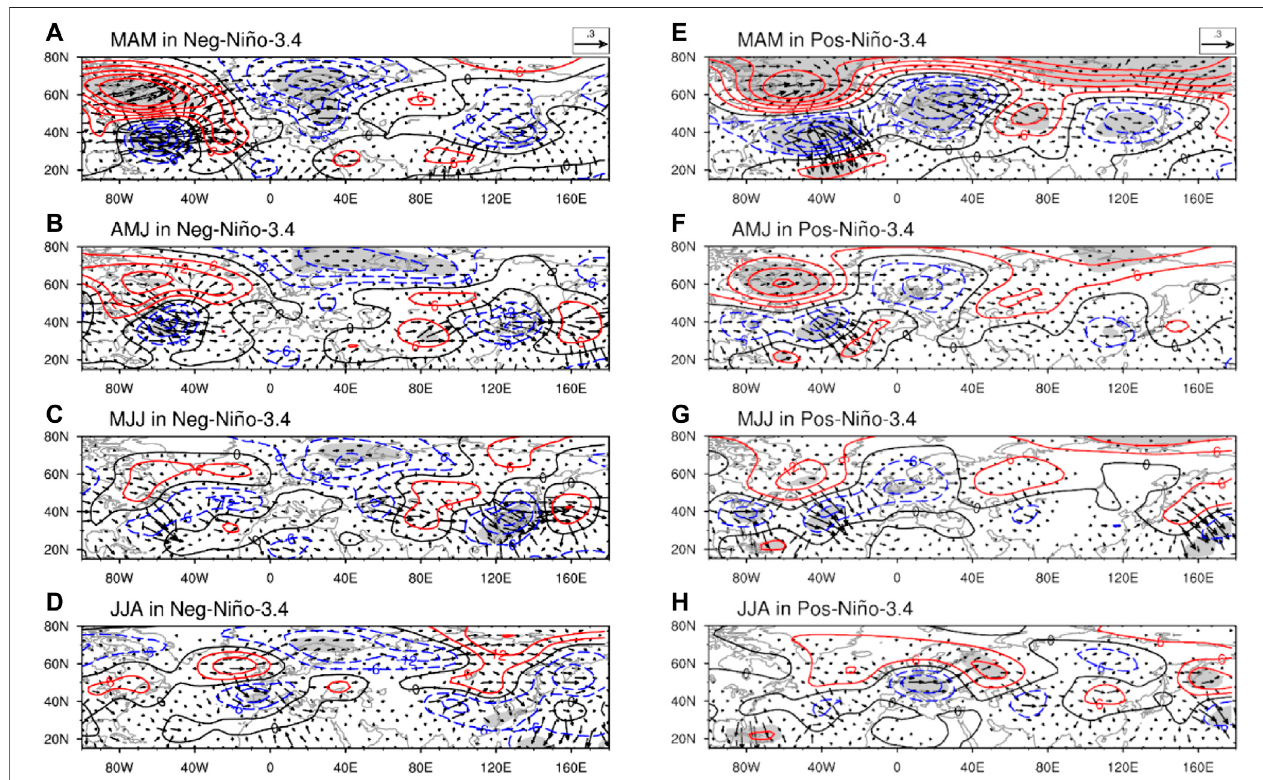
FIGURE9| Regressionofspringtosummer200-hPageopotentialheight(contours,m)andwaveactivity fl uxes(arrows,m 2 /s 2 )onto (left) SST-AtlinnegativeNiño- 3.4 summers and (right) SST-Atl-P in positive Niño-3.4 summers. Shading indicates the 90% con fi dence level. All variables are detrended during 1979 – 2019.